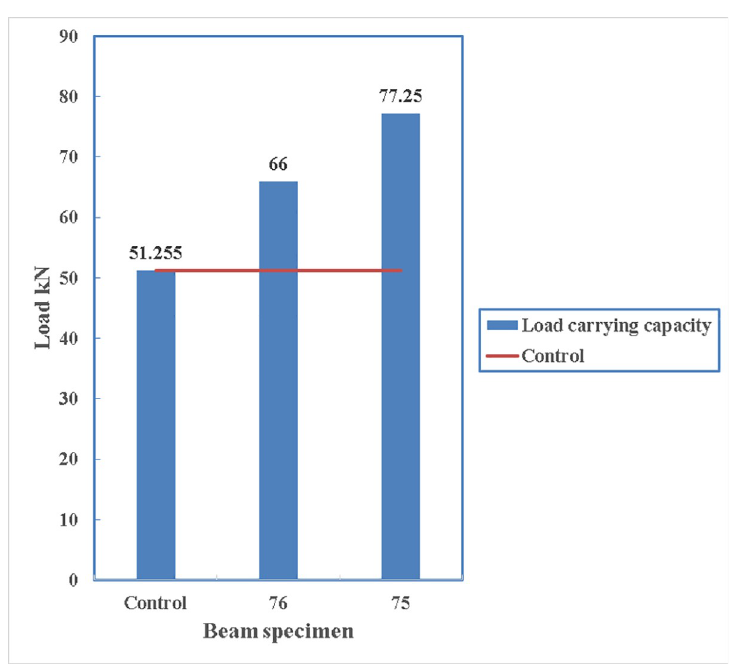
Fig 30. Load carrying capacity of beam 75 and beam 76.